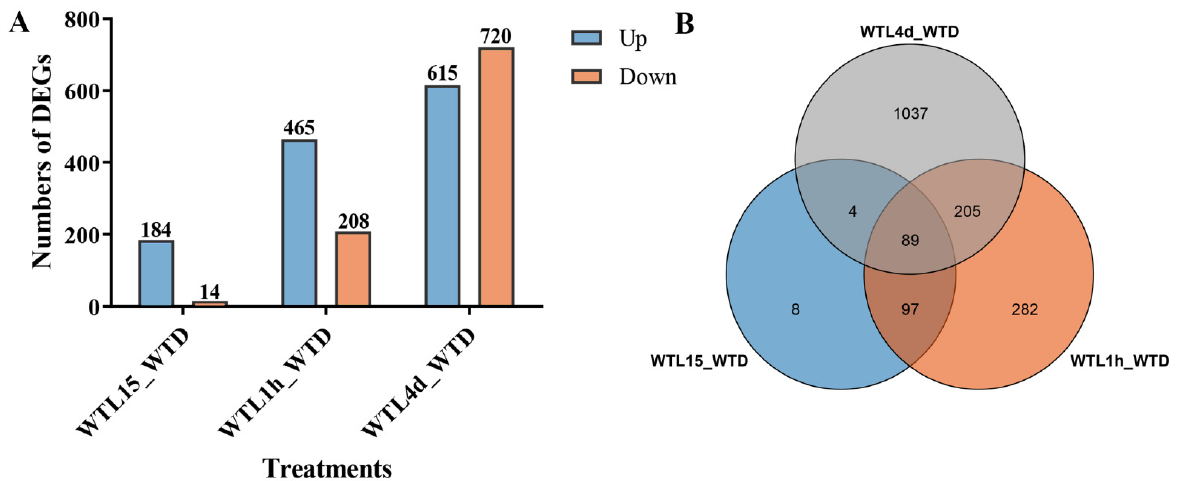
Figure 2. Analysis of DEGs between treatments with different light exposure time in WT strain. The number of genes differentially expressed after light exposure for 15 min, 1 h, and 4 d. Number of DEGs is indicated on the top of the histograms ( A ). Venn diagram of DEGs among the treatments with light exposure for 15 min, 1 h, and 4 d ( B ).